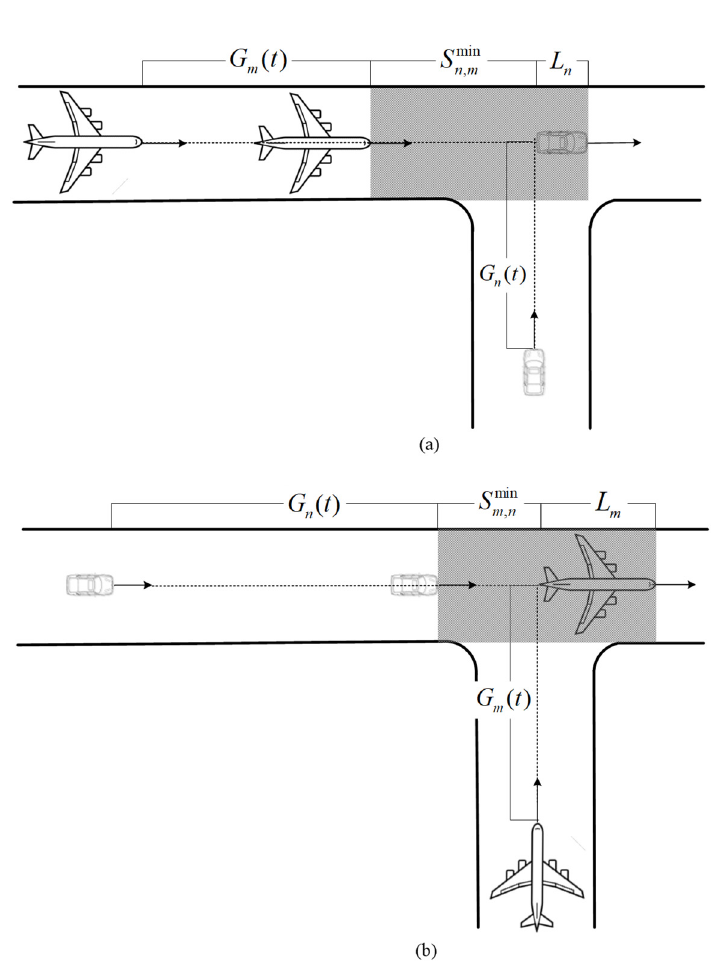
Figure 2. Scenarios of Vehicle-Aircraft Cross Convergence. ( a ) A vehicle crosses the intersection first; ( b ) Aircraft crosses the intersection first.